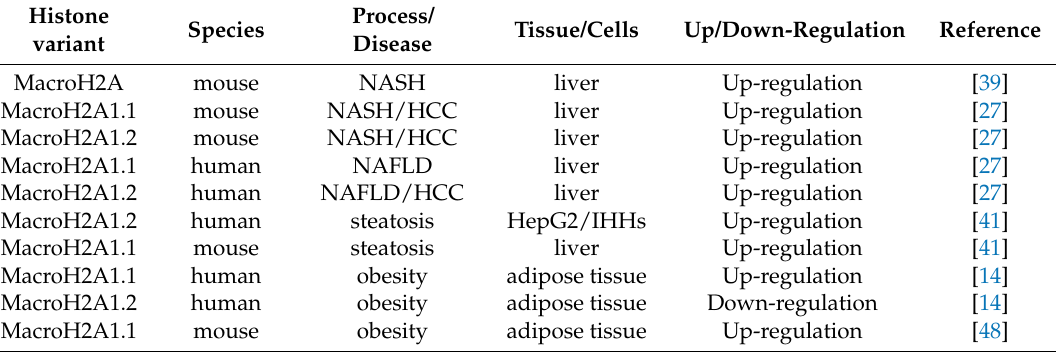
Table 1. Altered expression of histone variants associated with diseases of lipid homeostasis.